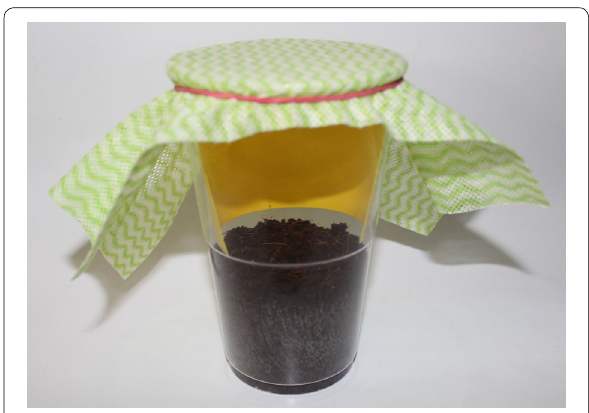
Fig. 1 Example of a suitable test vessel covered with cotton cloth and equipped with yellow sticky